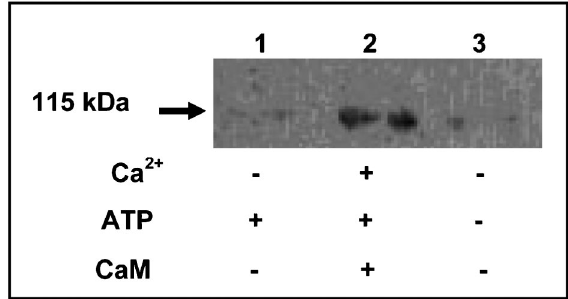
Figure 6. Effect of calmodulin (CaM) on total and thapsigargin (Tg)-sensitive 45 Ca 2 + uptake by vesicle membranes from the SERCA-enriched fraction. 45 Ca 2 + uptake without (black columns; controls) or with 2 m M exogenous calmodulin (gray columns). The assays were performed in triplicate and the data are reported as means ± SE for 4 experiments using 4 different preparations. SERCA = sarco(endo)plasmic reticulum Ca 2 + -ATPase. *P , 0.05 compared to control (one-way